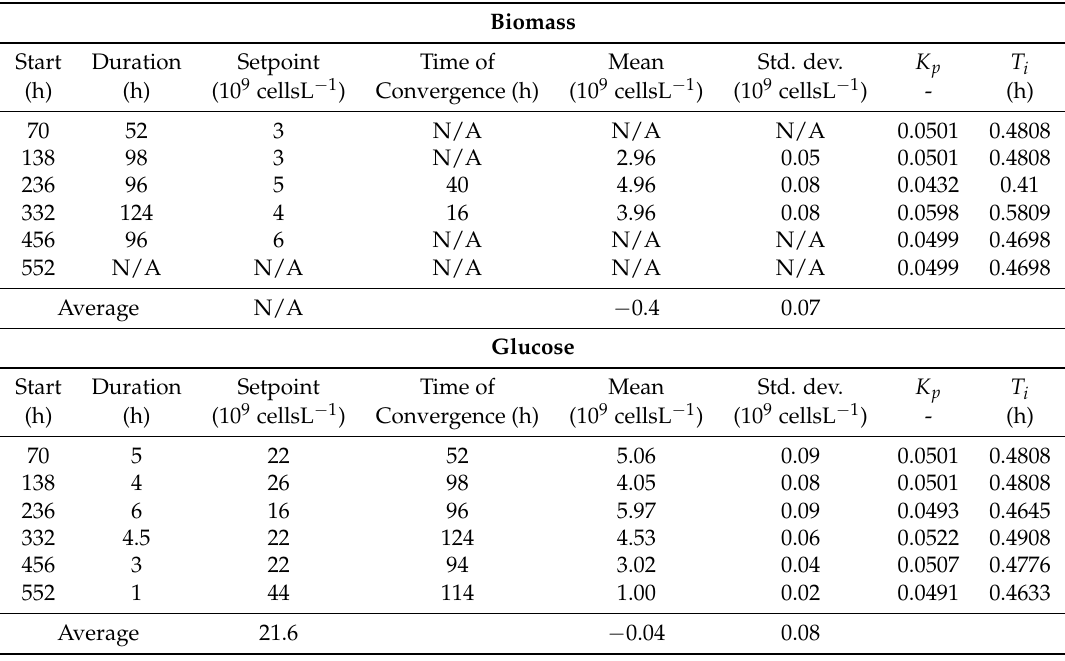
Table 3. Summary of the results obtained using the control